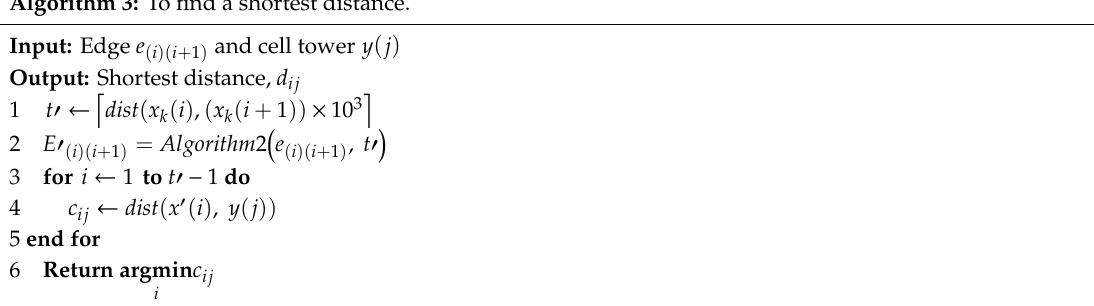
Algorithm 3: To find a shortest